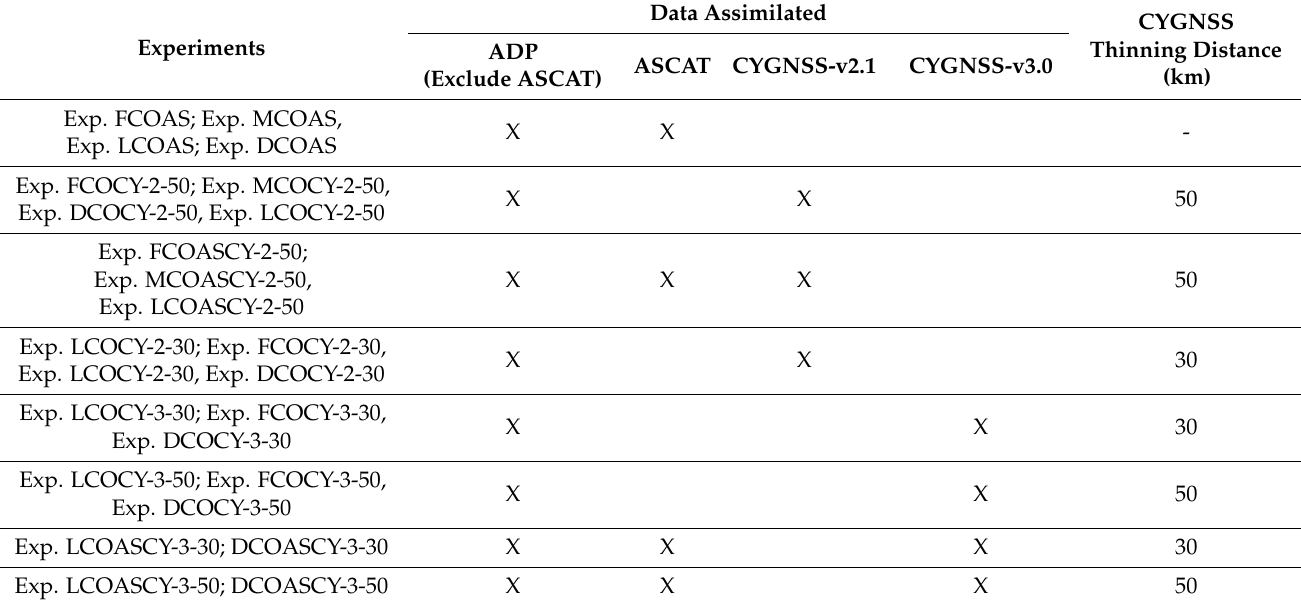
Figure 2. Available CYGNSS data of ( a ) version 2.1 and ( b ) version 3.0 on 13 September 2018 at different assimilation times, represented by different colored dots (red, blue, green, and grey colors for 00 UTC, 06 UTC, 12 UTC, and 18 UTC, respectively), and ( c ) comparison of uncertainty (the wind speed error) between these two versions of CYGNSS wind data (black and red colors denote version 2.1 and version 3.0 data, respectively). Table 1. Configurations for all data assimilation experiments. ADP represents ADP conventional data used in NCEP operational analysis. In the experiment names, “F” stands for Florence, “M” for Michael, “L” for Laura, and “D” for Delta.